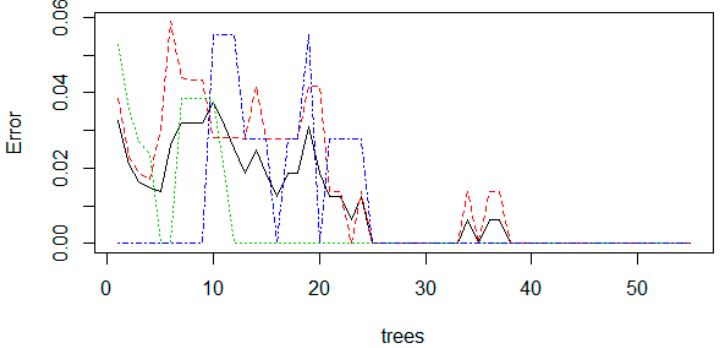
Figure 7. The random forest algorithm used in LEWS. The black line represents the out-of-bag error. The red, green, and blue lines represent the uncertainties in predicting each class (1 Low, 2 Medium, and 3 High, respectively).